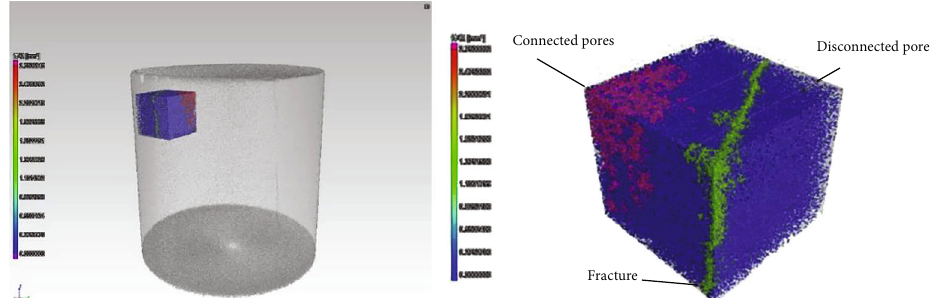
Figure 8: CT scan and fi ne analysis of Core No.10 in Well